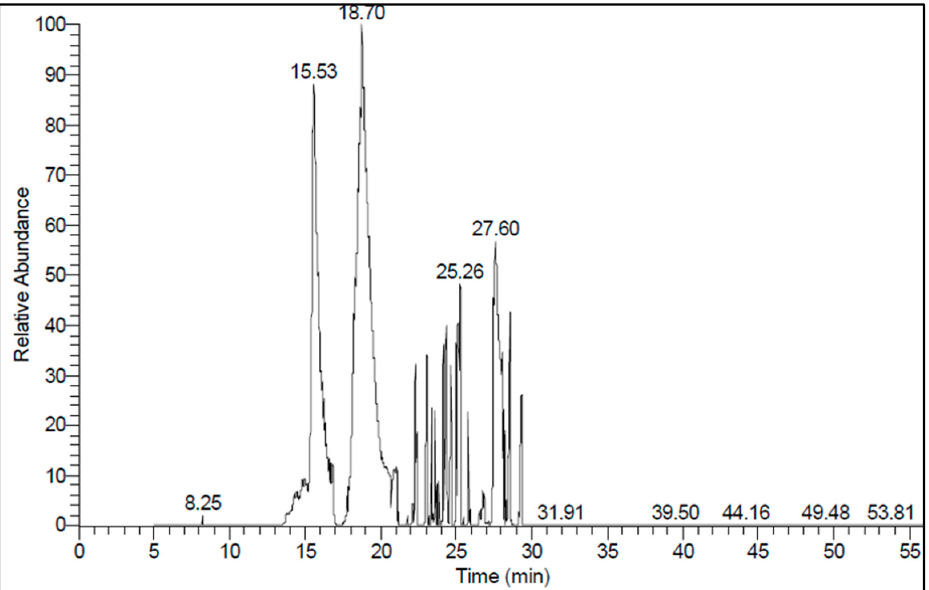
Figure 1. Gas chromatography–mass spectroscopy chromatogram of anise oil.